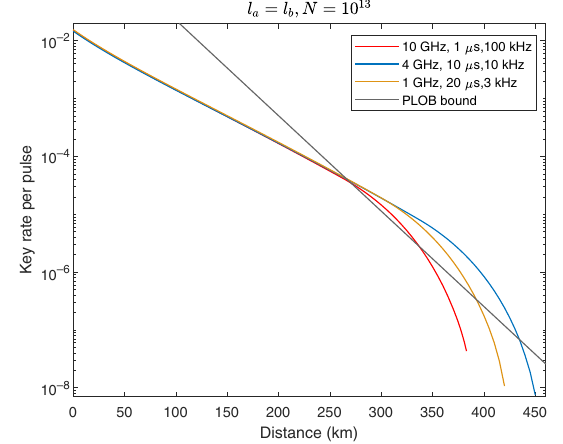
FIG. 8. Secret key rates of our protocol with short-term match- ing as a function of the distance where both phase tracking and phase locking are not adopted. Different system repetition rates F , matching time intervals T c , and frequency differences δv are taken into consideration. Red line denotes F = 10 GHz, T c = 1 μ s, δv = 100 kHz; blue line denotes F = 4 GHz, T c = 10 μ s, δv = 10 kHz; yellow line denotes F = 1 GHz, T δv = 3 kHz. Our protocol can overcome the PLOB bound at 270 km with a key rate of 2 × 10 − 5 .